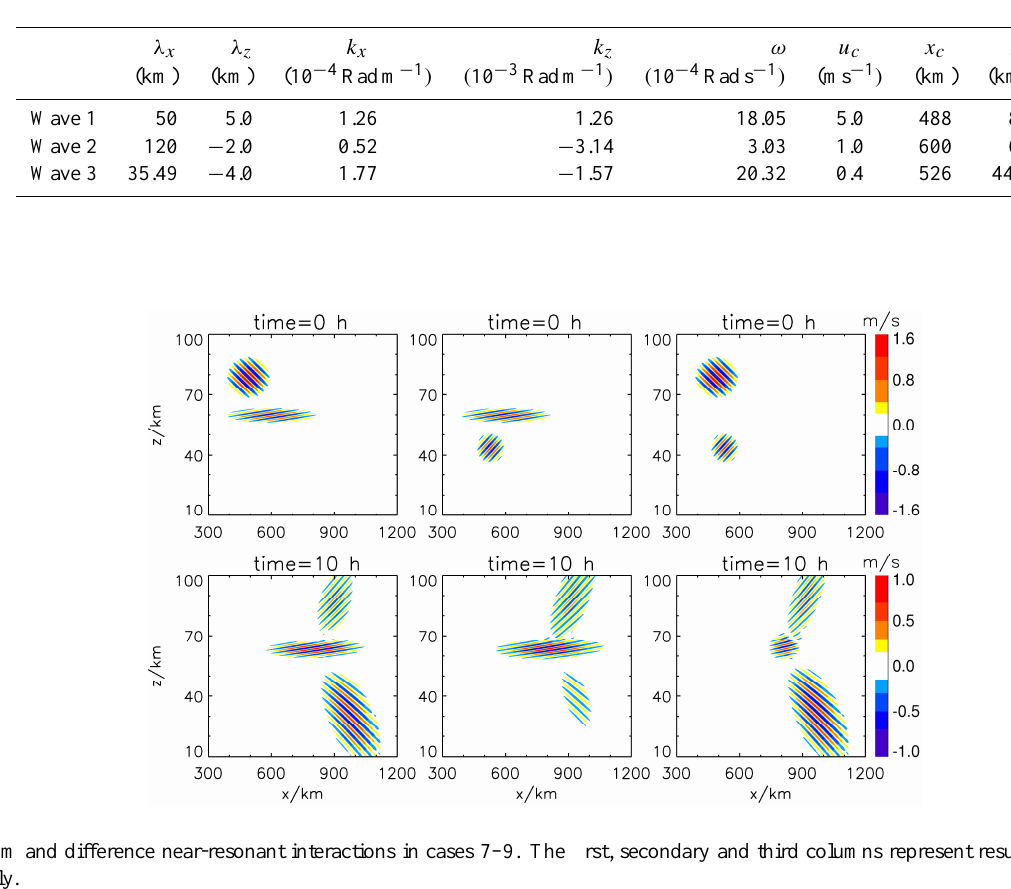
Table 3. Initial parameters of waves 1–3 regarded as initial perturbations in cases 7–9.